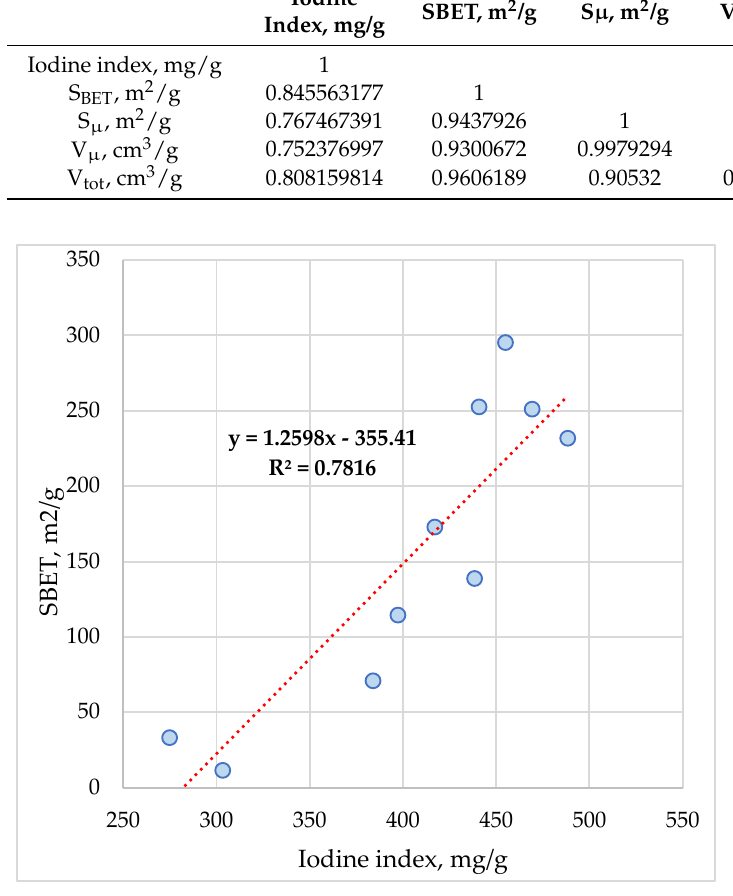
Figure 12. Variation between S BET and iodine index of ACMP.